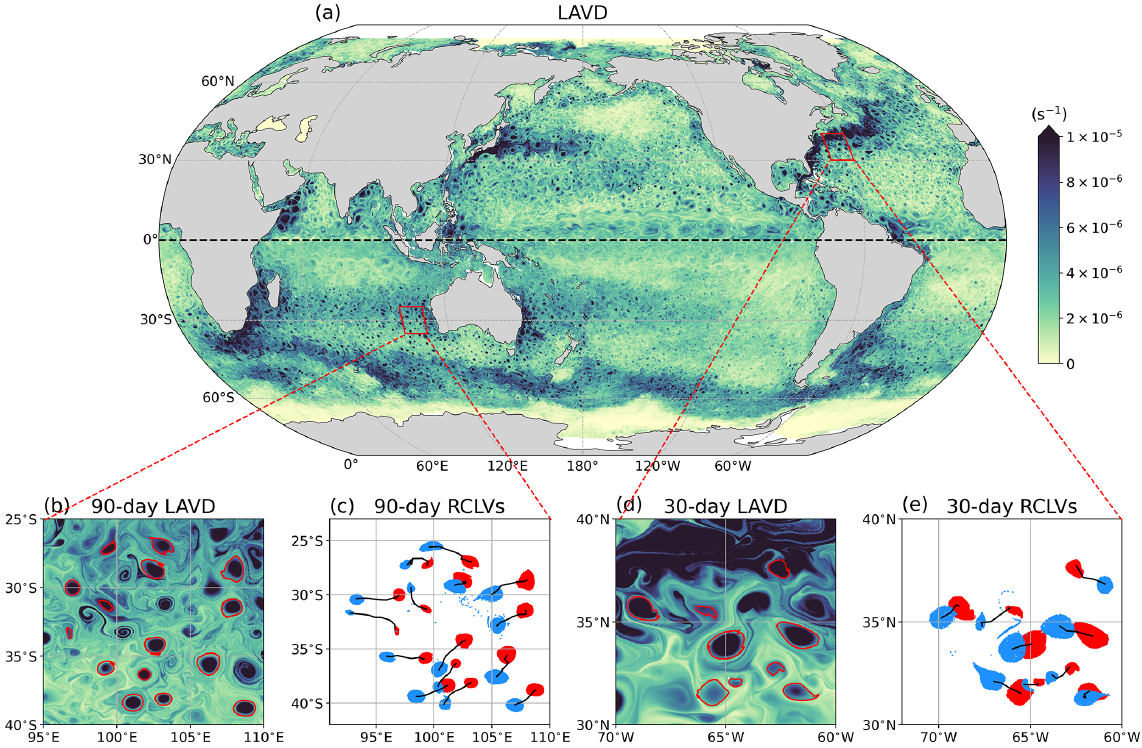
Figure 4. (a) 30d LAVD (s − 1 ) field in the Northern Hemisphere and 90d LAVD field in the Southern Hemisphere calculating from 1 October 2016. (b) Identified boundaries (red contours) of 90d RCLVs in the west of Australia. (c) Initial (red dots) and final (blue dots) positions of 90d RCLVs, with black lines representing the eddy center trajectories. (d) Identified boundaries (red contours) of 30d RCLVs in the Gulf Stream region. (e) Initial (red dots) and final (blue dots) positions of 30d RCLVs, with black lines representing the eddy center trajectories.